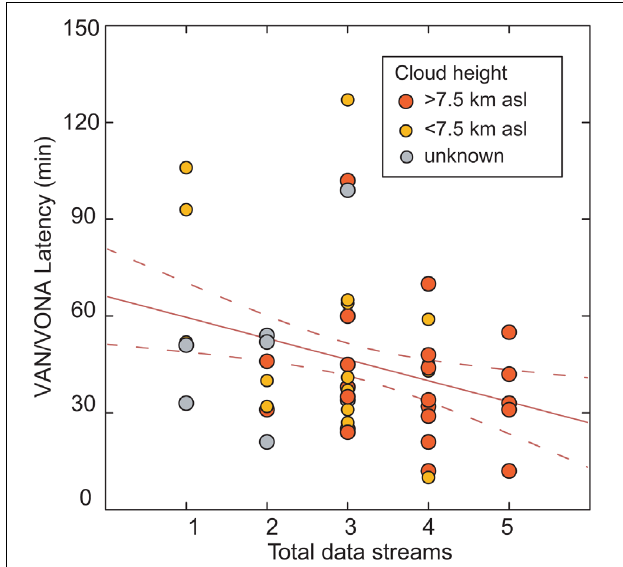
FIGURE 9 | Scatter plot showing latency of VAN/VONA, in minutes, versus number of monitoring data streams (seismicity, infrasound, satellite remote sensing, lightning, and/or observer reports) available for each explosive event. This plot excludes explosions for which precursory seismicity was detected, which highlights that when trying to characterize detected events, more data streams decrease uncertainty and lead to faster notifications. FIGURE 10 | Box-whisker plots showing effects of the presence or absence